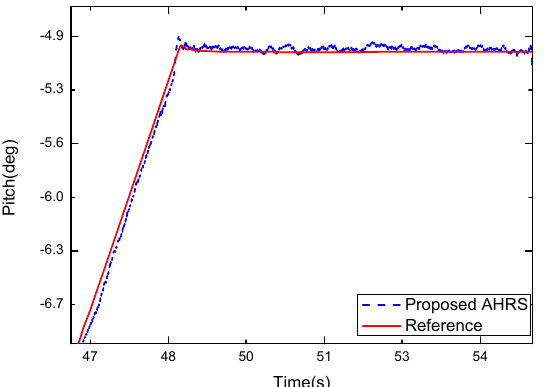
Figure 11. Zoomed-in view of the pitch estimate (dash curve) from the Kalman filter and the turntable reference (solid curve).